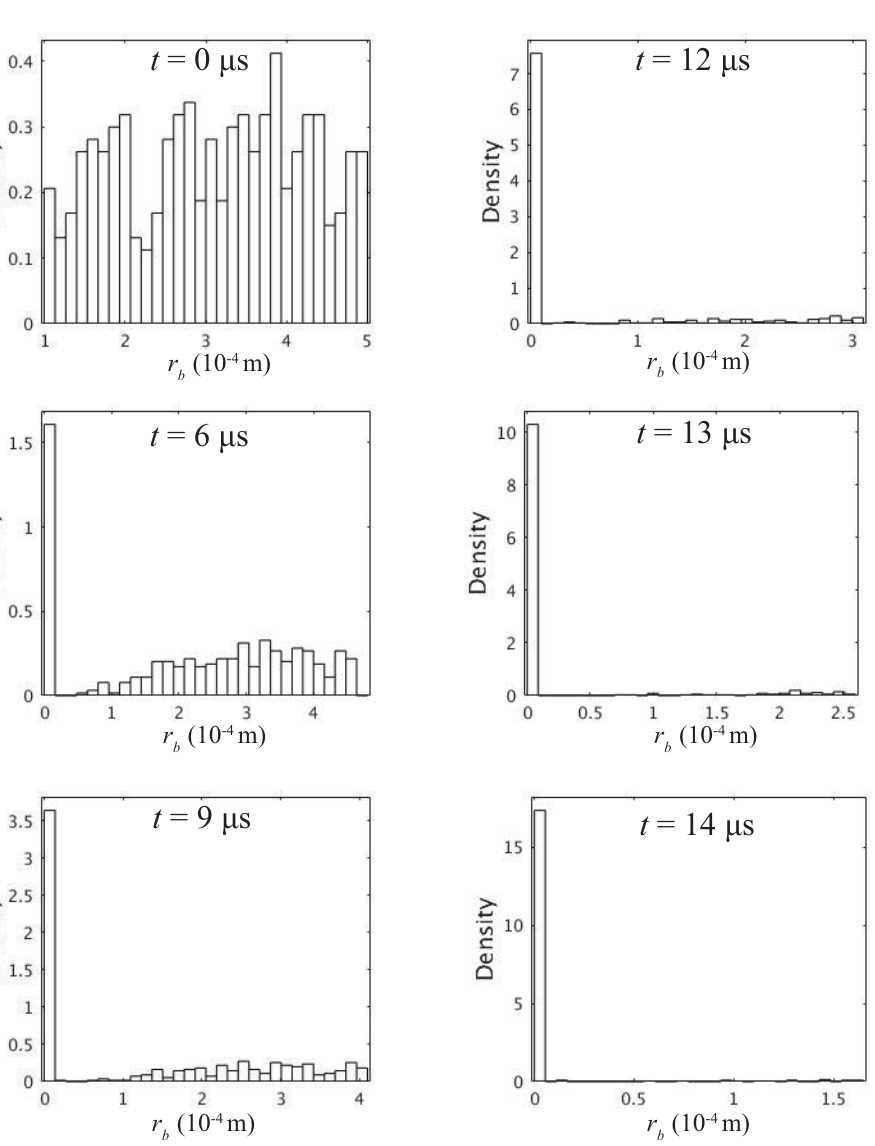
Figure 19. The bubble distributions (radii density bar graphs) of the bubbles’ radii at t = 0 µ s, 6 µ s, 9 µ s, 12 µ s, 13 µ s, and 14 µ s. The first bar from the left side indicates the density of the collapsed vapor